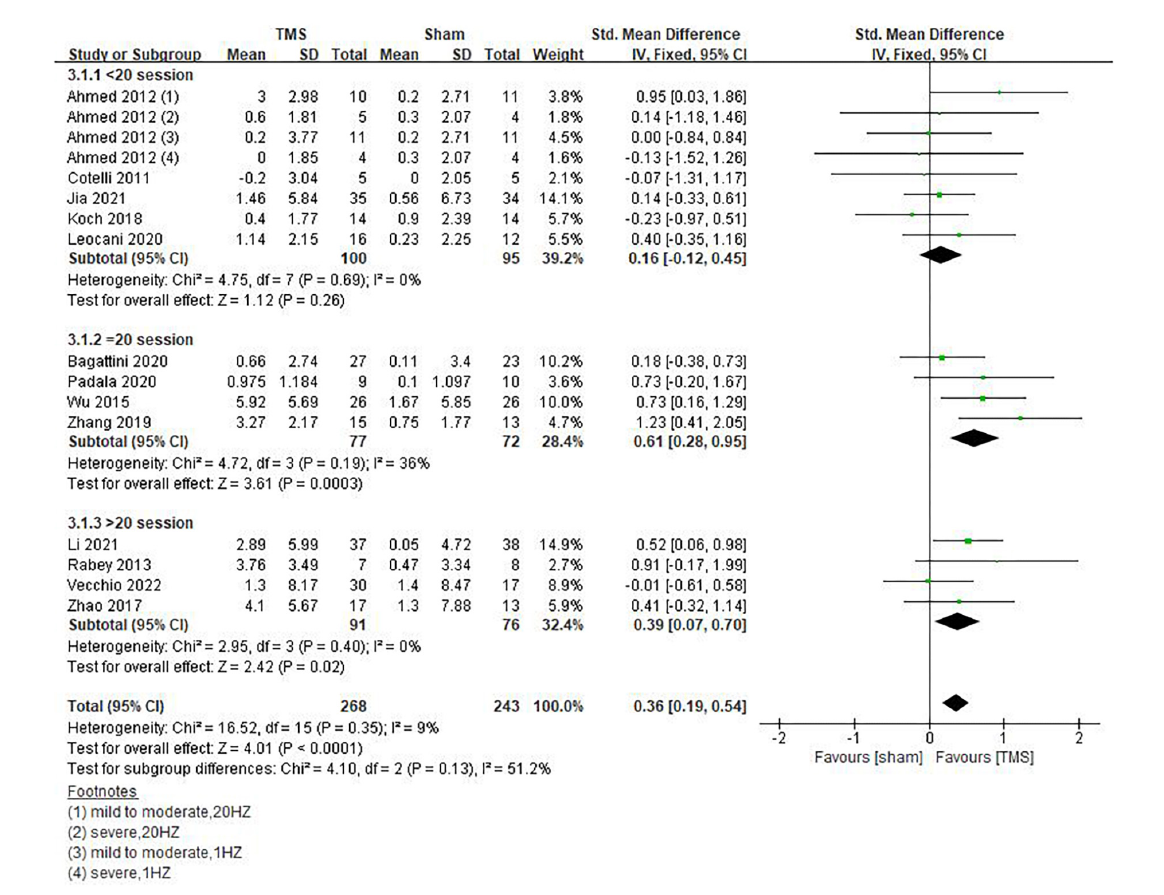
FIGURE6 Influence of sessions of repetitive transcranial magnetic stimulation (rTMS) treatment on global cognitive